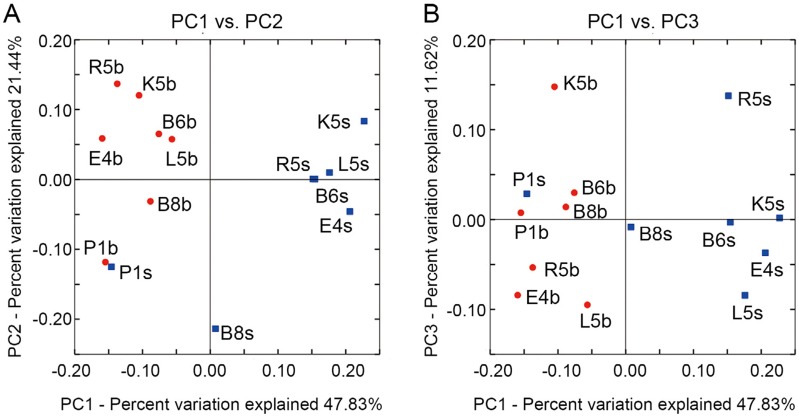
Spatial variations of bacterial communities are exhibited by principal coordinates analysis (PCoA) with the coordinates PC1 and PC2 (A), and the coordinates PC1 and PC3 (B).Samples from surface and bottom water are labeled with blue squares and red dots.